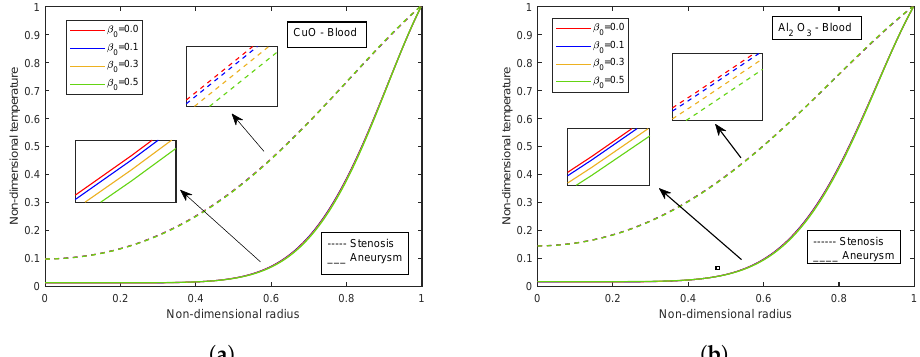
Figure 18. Impact of viscosity parameter β 0 on temperature profiles for ( a ) CuO-nanoparticles, ( b ) Al 2 O 3 -nanoparticles.